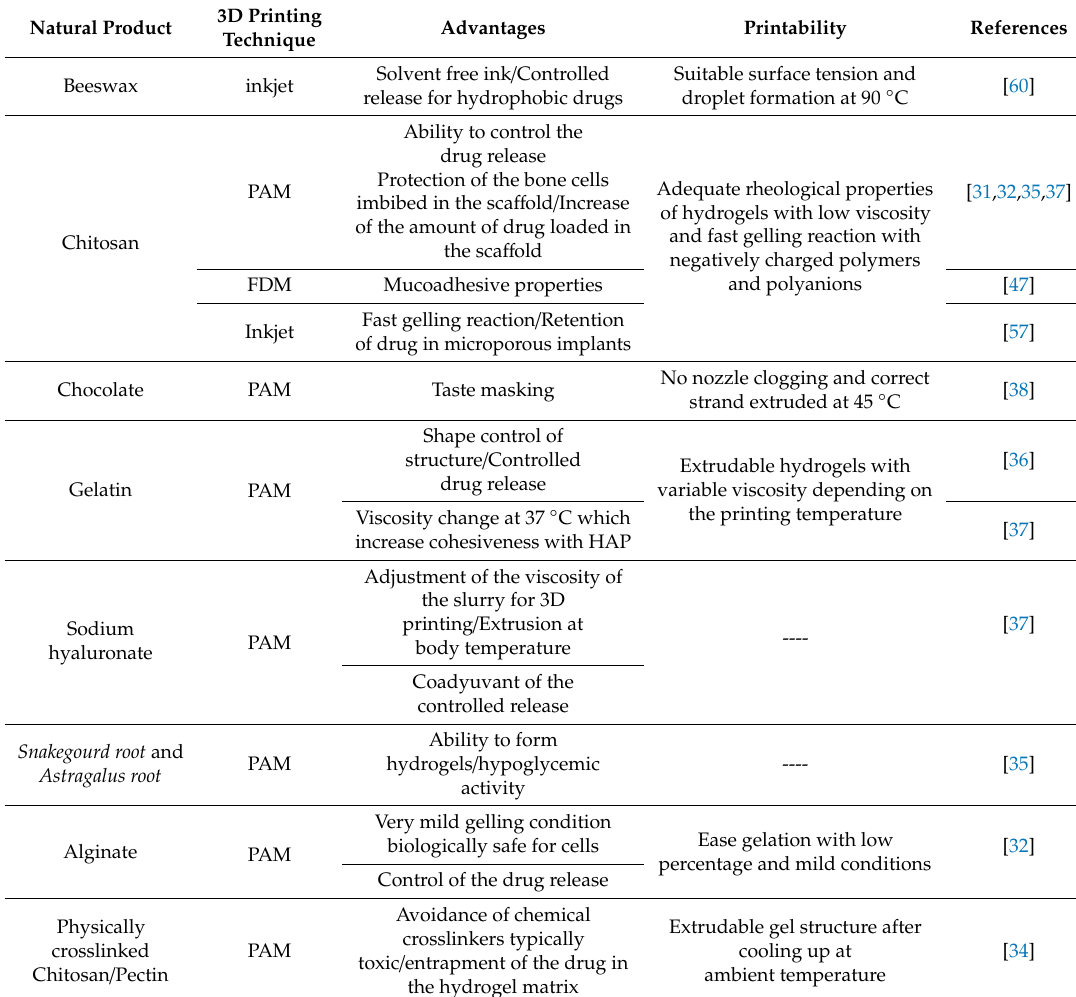
Table 4. Advantages of the employment and printability of natural products in 3D printed pharmaceutical